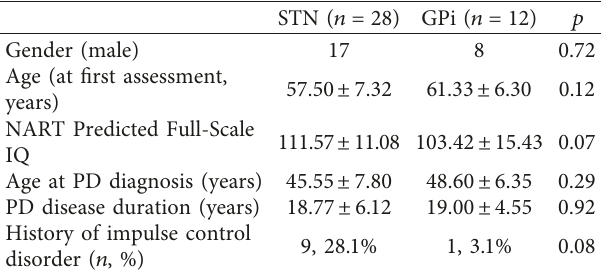
Table 1: Patient demographic